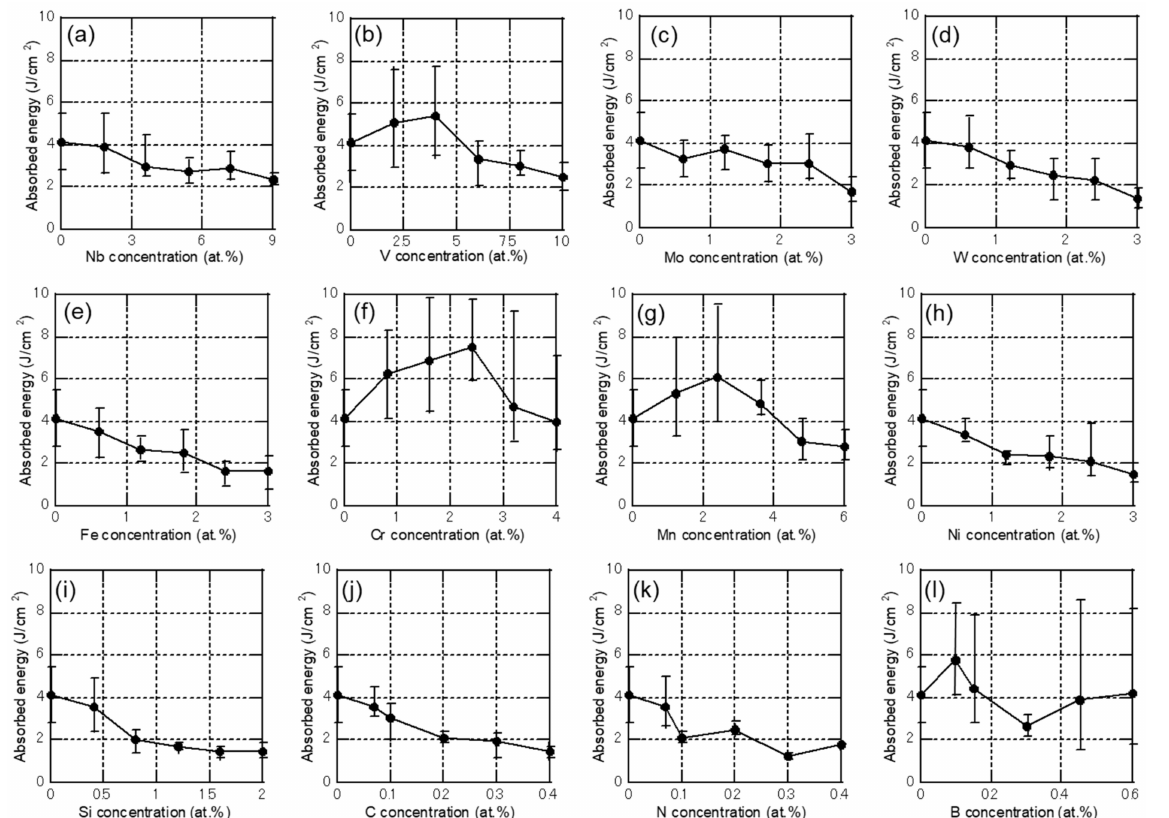
Figure 4. Charpy absorbed energies of the Ti-Al-X ternary alloy in the as-cast state: ( a ) Nb; ( b ) V; ( c ) Mo; ( d ) W; ( e ) Fe; ( f ) Cr; ( g ) Mn; ( h ) Ni; ( i ) Si; ( j ) C; ( k ) N; and ( l )